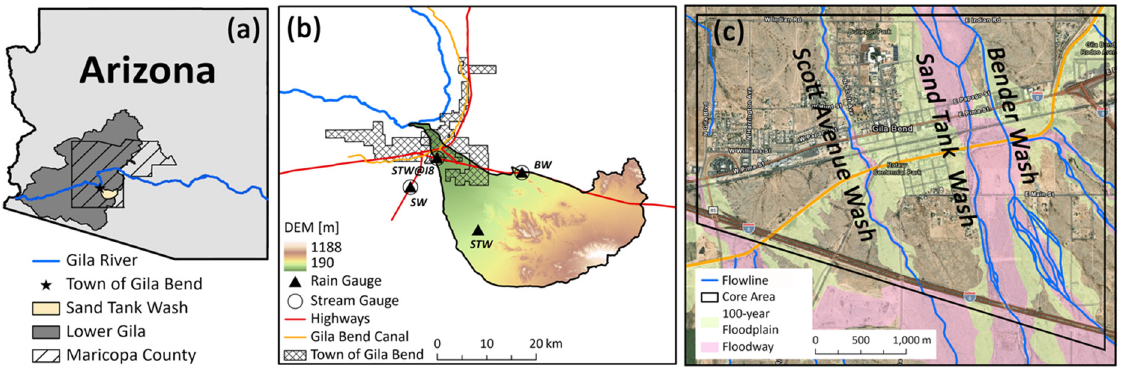
Figure 1. Study area. ( a ) Location of the town of Gila Bend in Arizona. ( b ) Digital elevation model (DEM) of the Sand Tank Wash watershed, with relative locations of key infrastructure, precipitation gauges, and streamflow gauges. ( c ) The core area of Gila Bend, overlaid with flowlines from the USGS and 100-year floodplain and floodway map from FEMA.